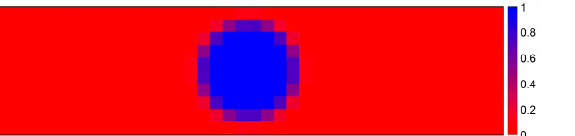
Figure 14. Monte Carlo simulation showing the probability to identify each SPAD of the 10 × 40 SPAD array as being inside the laser spot, when a 130 µm FWHM Gaussian spot hits the array, in the worst signal to background ratio conditions.